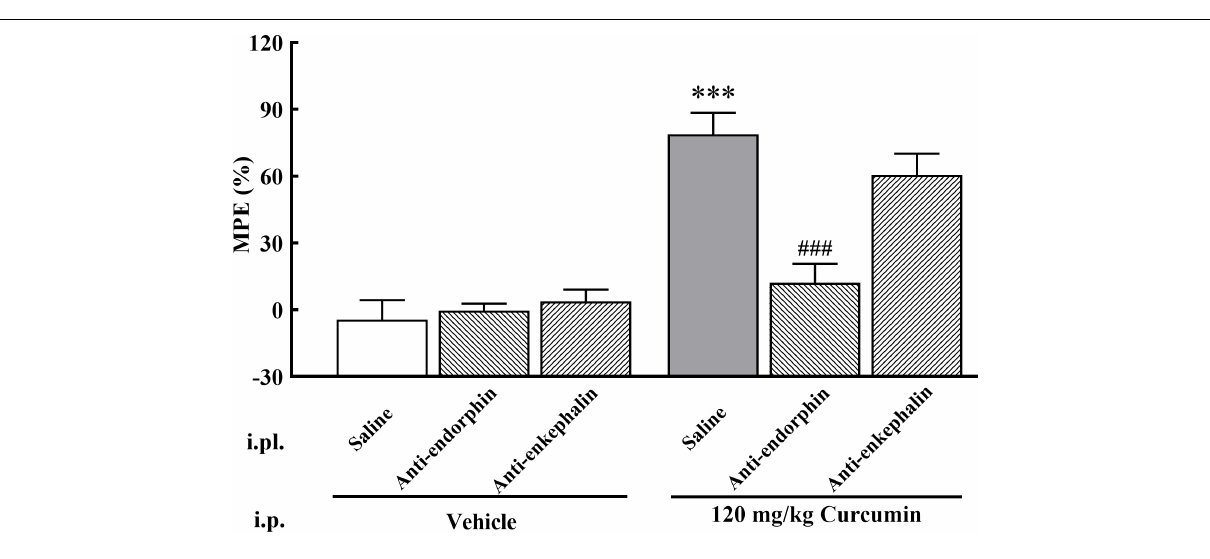
FIGURE 5 | Effect of β -endorphin and enkephalin antiserum pretreatment on the anti-allodynia activity of curcumin in cancer-induced bone pain mice. Mice were treated with curcumin (120 mg/kg, i.p.) twice a day for 11 days after the injection of B16-F10 melanoma cells (1 × 10 5 , 5 µ l). On the 11th day, β -endorphin and enkephalin antiserum (1:40 dilution, 20 µ l, i.pl.) were administered at 30 min prior to curcumin (120 mg/kg, i.p.) injection, respectively. MPE% induced by curcumin (120 mg/kg, i.p.) 4 h after administration was evaluated. Data are shown as means ± SEM, n = 6–7 per group. *** P < 0.001 compared with the saline +